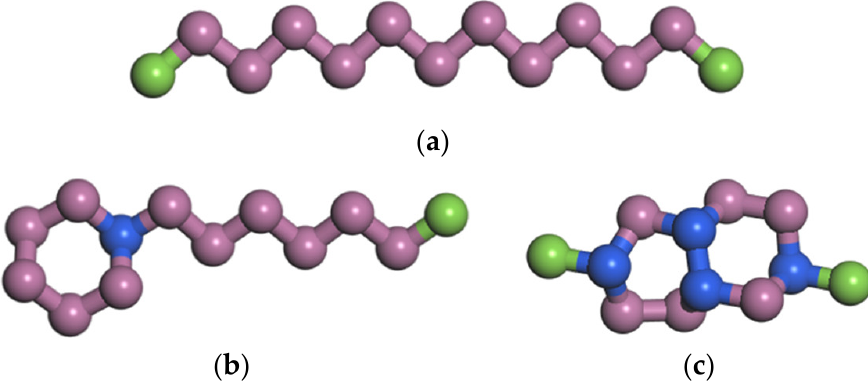
Figure 1. The molecular structure of ( a ) n-tridecane, ( b ) n-heptylcyclohexane, and ( c ) naphthalene, decahydro-2,6-dimethyl- in rocket kerosene. The green, pink and blue beads represent the CH3, CH2 and CH pseudoatomic groups, respectively .